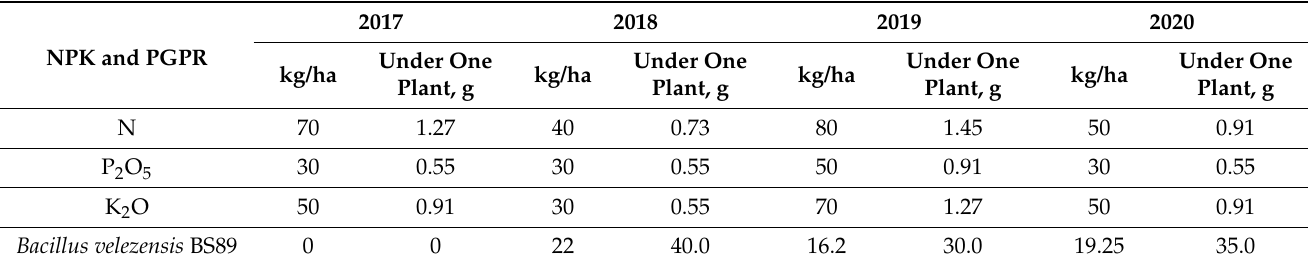
Table 1. Macroelements introduced during the study period (variants 2–7) and Bacillus velezensis BS89 (variants 5–8) under one plant per